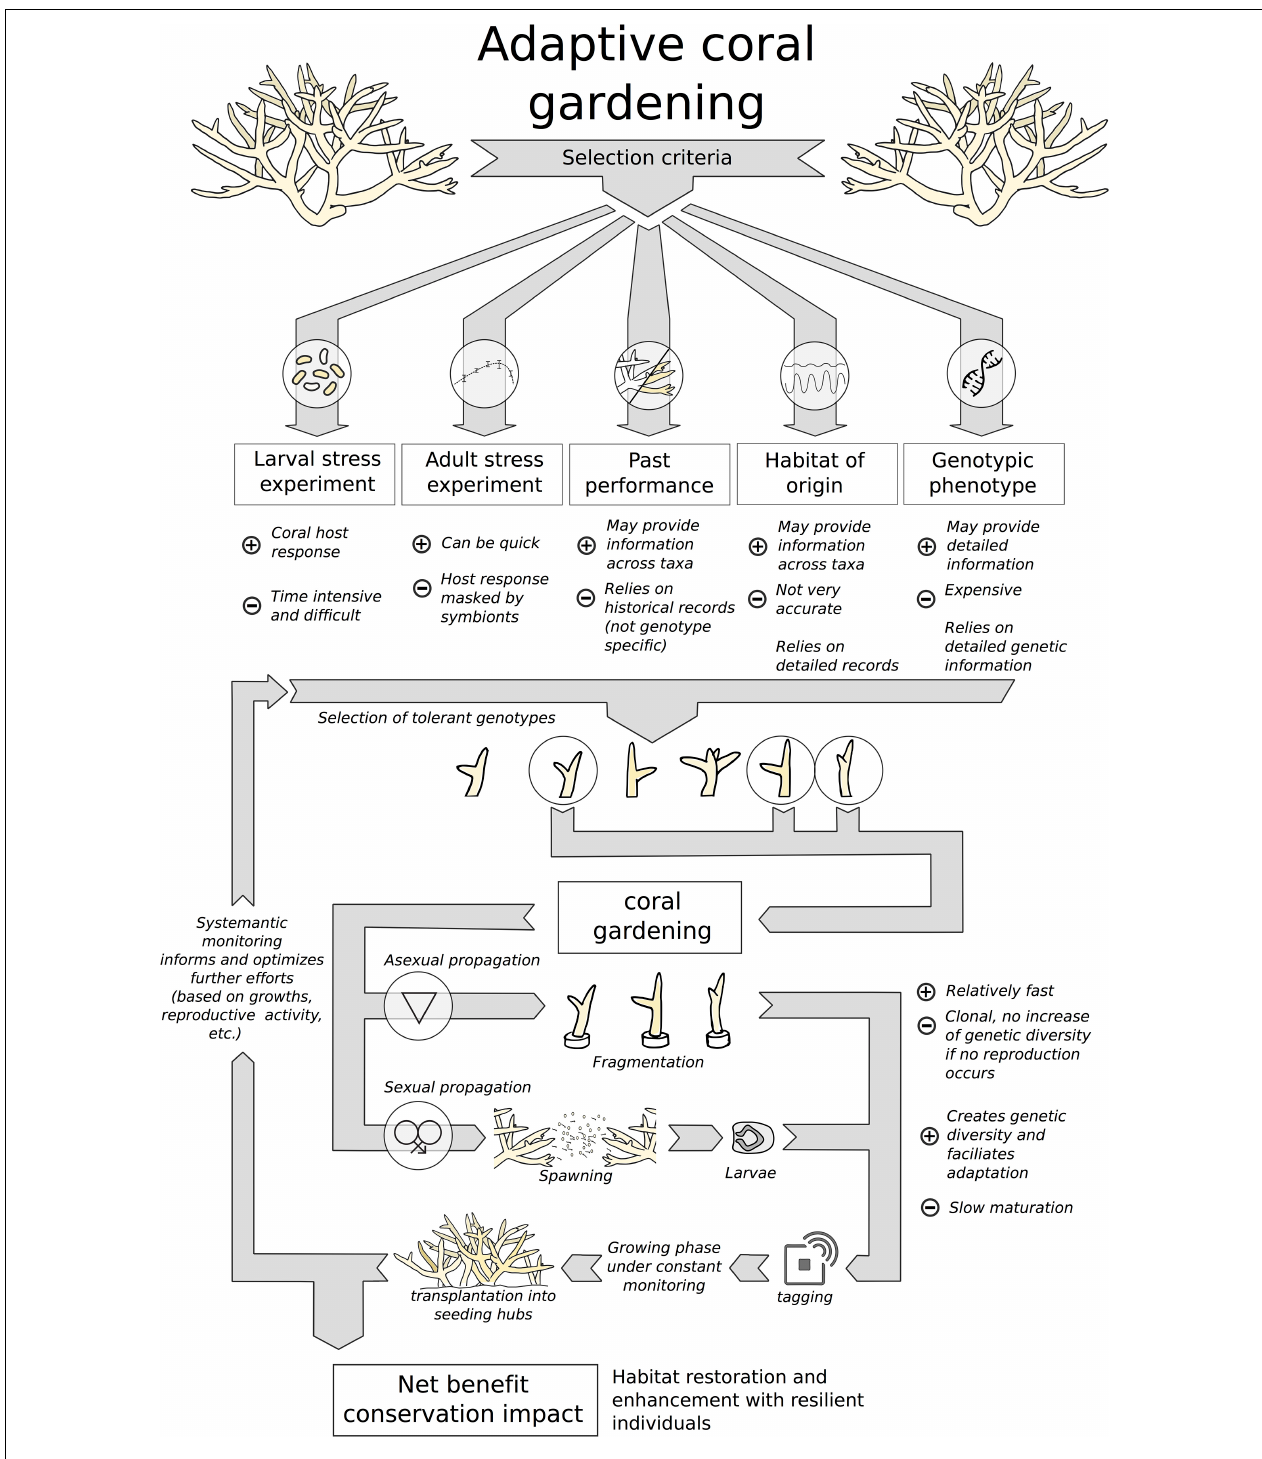
FIGURE 1 | Adaptive coral gardening with pre-selected genotypes to increase resilience.